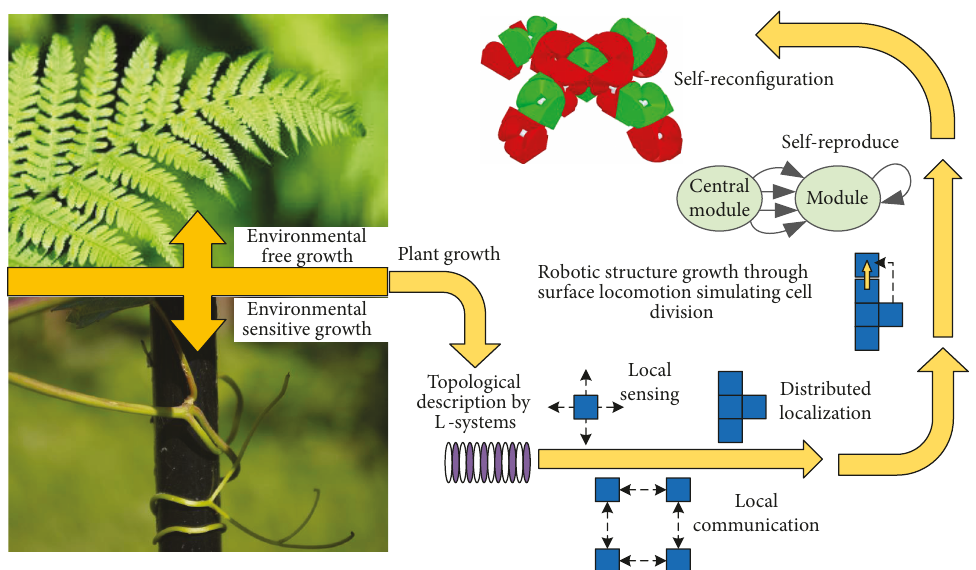
Figure 1: Plant growth-inspired self-recon fi